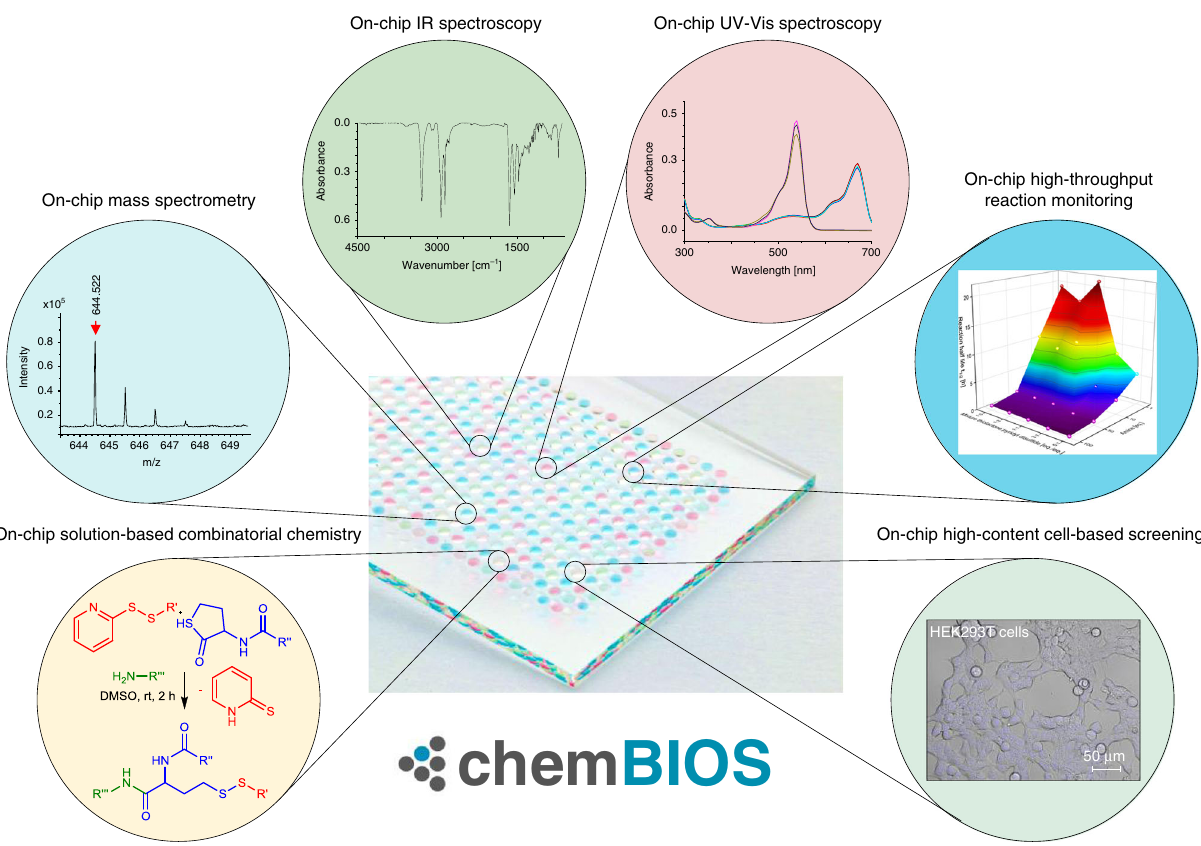
Fig. 1 Chemical, analytical, and biological high-throughput methods compatible with the chemBIOS platform. ChemBIOS enables on-chip solution-based synthesis, on-chip analytical characterization using various spectrometric and spectroscopic approaches for high-content screening and also uni fi es chemistry with biological high-throughput screening using nanodroplet (Fig. 3d, Supplementary Fig. 2 and Supplementary Table 2). The thickness of each dendrimeric layer increased by 1.1 ± 0.2 nm per